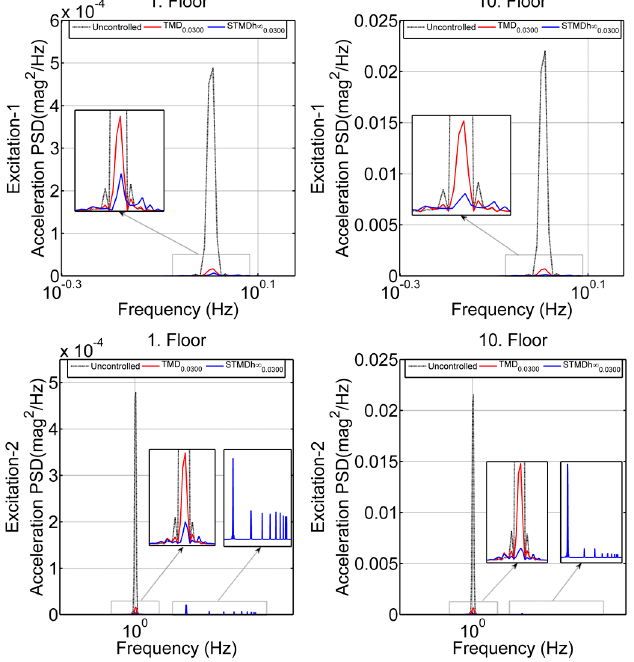
Figure 15. Acceleration PSD curves of the system first (left) and 10th (right) floors under the Excitation-1 (top) and Excitation-2 forces (bottom).